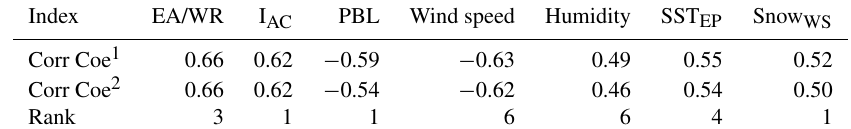
Table 1. Correlation coefficients between the DHD NH and key indices from 1979 to 2016 and the ranks of key indices in 2016. The Corr Coe 1 and Corr Coe 2 indicated that correlation coefficients were calculated after and before detrending. The I AC was the anti-cyclone index that was defined as the mean Z500 over 105–125, 30–50 ◦ E. The local PBL, surface wind speed, and relative humidity were calculated as the mean over the NH area. All the correlation coefficients were above the 99% confidence level. The rank was sorted from largest to smallest, when the Corr Coe was positive. If the Corr Coe was negative, the rank was calculated from smallest to largest.